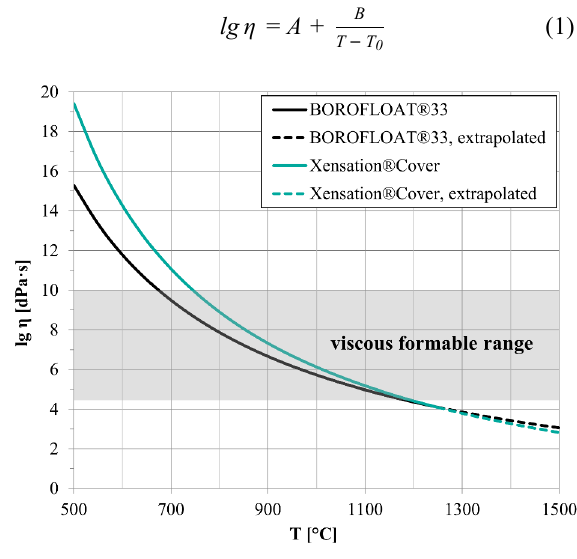
Fig. 1. Viscosity-temperature curves of the materials used